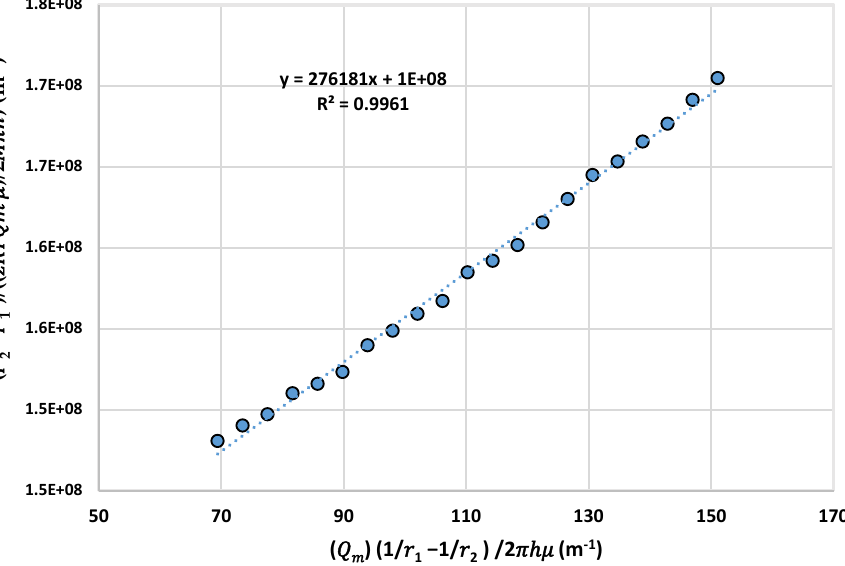
Figure 5. Calculating the non-Darcy β . Permeability = 2, Darcy.